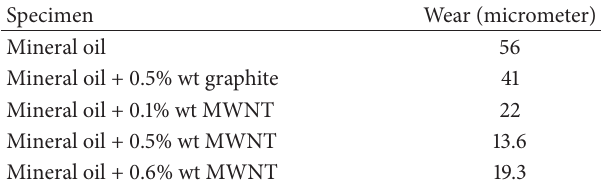
Table 7: Pin on disk test results.